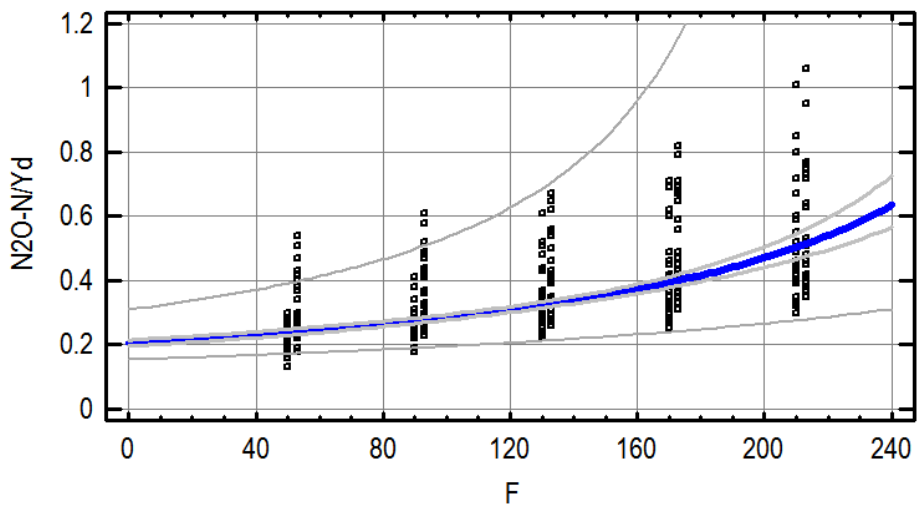
Figure 6. Observed and predicted yield-scaled N 2 O emissions (N 2 O/Yd, kg N · Mg − 1 ) depending on nitrogen doses (F, kg N · ha − 1 ) (R 2 = 47.0%, n = 320). The regression between NH 3 /Yd and N rates was described by the reciprocal-Y model: NH 3 /Yd = 1/(6.58 − 0.0226*F), R 2 = 48.0% (Figure 7). The estimated NH 3 /Yd values for the critical doses of F 112 and 149 kg N · ha − 1 were 0.25 and 0.31 kg N · ha − 1 ,